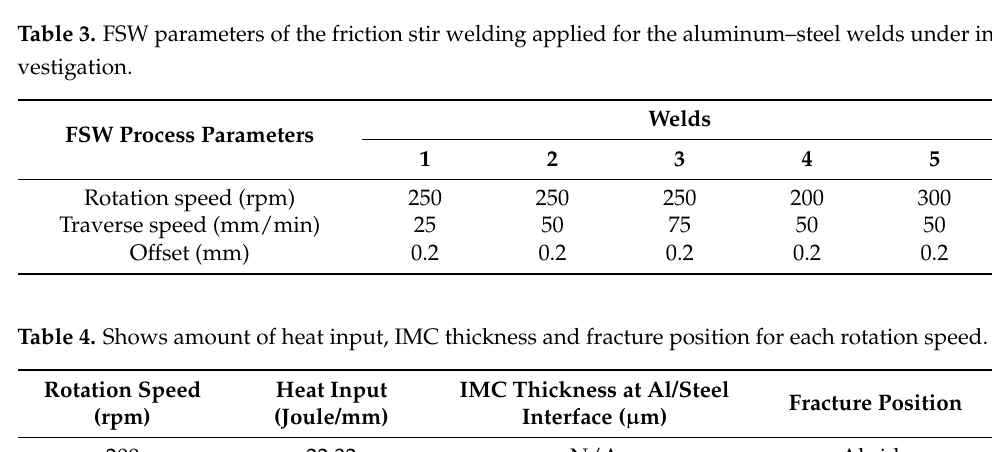
Table 3. FSW parameters of the friction stir welding applied for the aluminum–steel welds under in- vestigation.